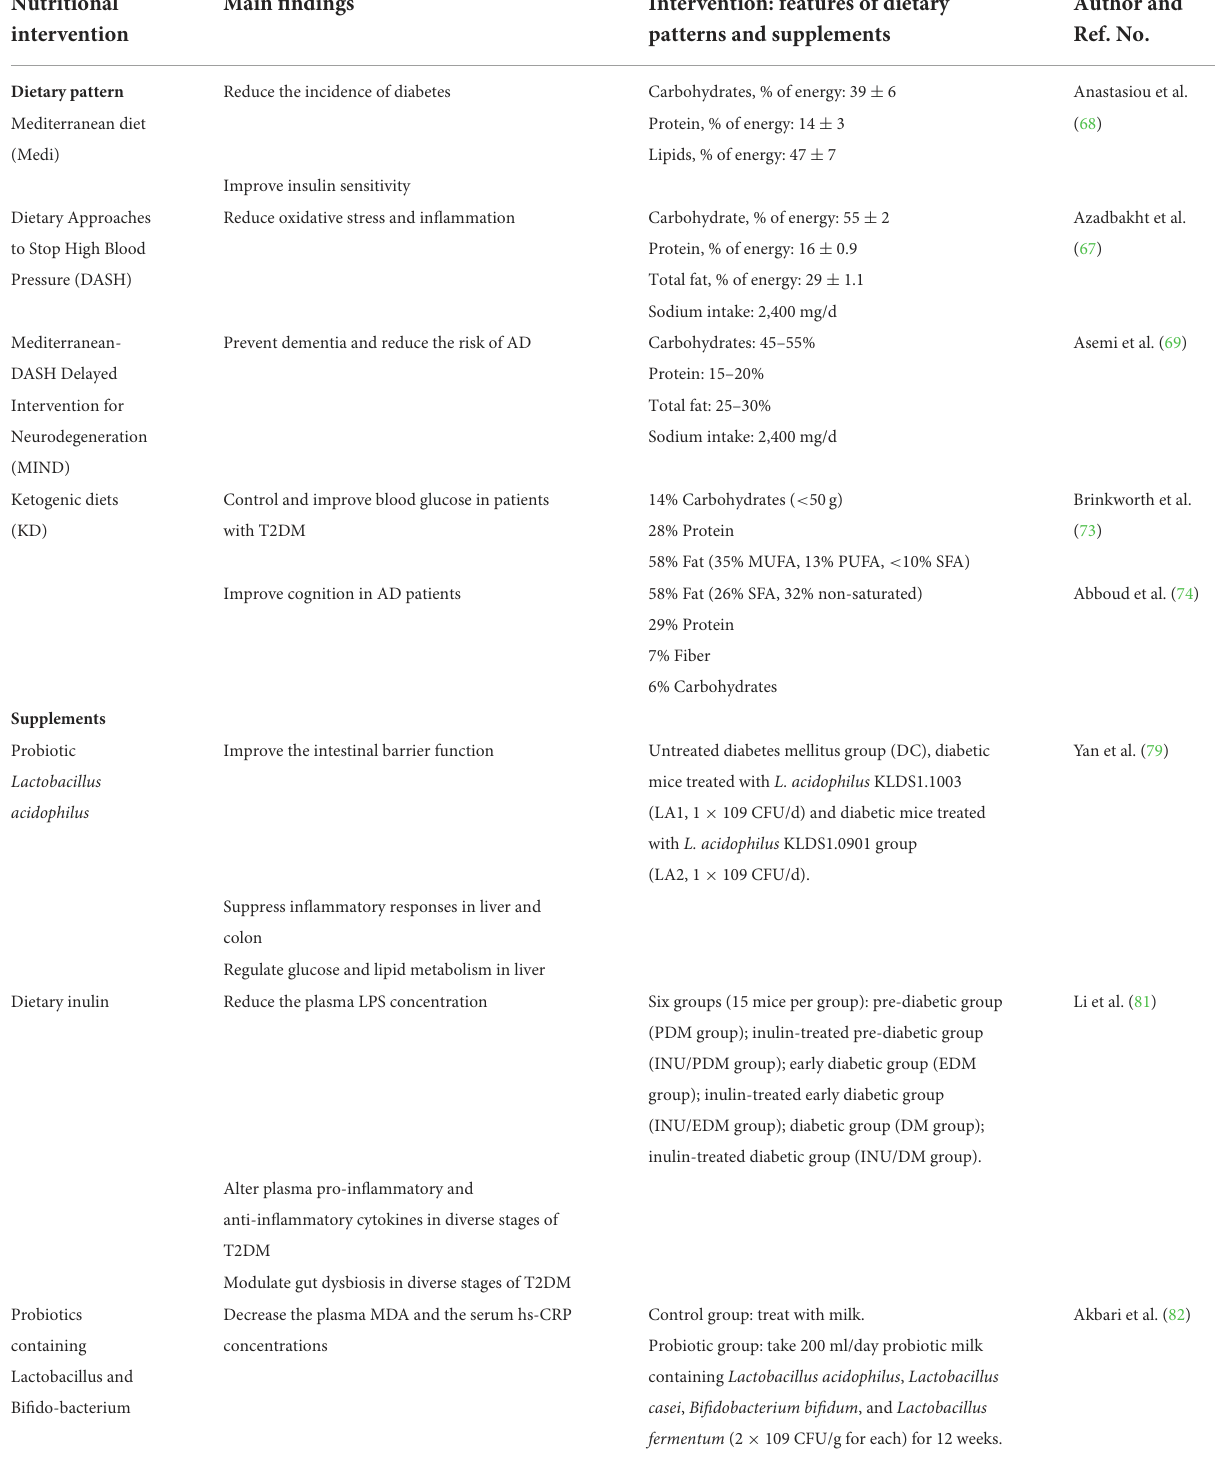
TABLE 1 The effects of nutritional intervention for diabetes mellitus with Alzheimer’s